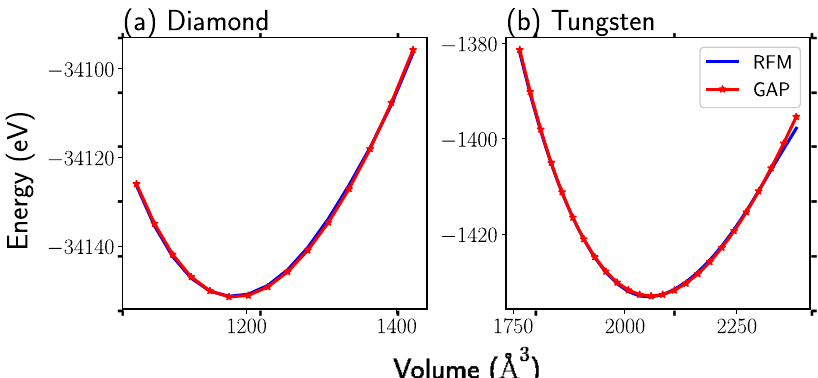
Fig. 4 Fitting equation of states for diamond and tungsten data. Energy volume relation for a diamond and b BCC-tungsten. The relations are obtained using RFM (blue) and GAP (red) 7,31 IP, by fi tting Birch − Murnaghan equation of state 48 to energy − volume